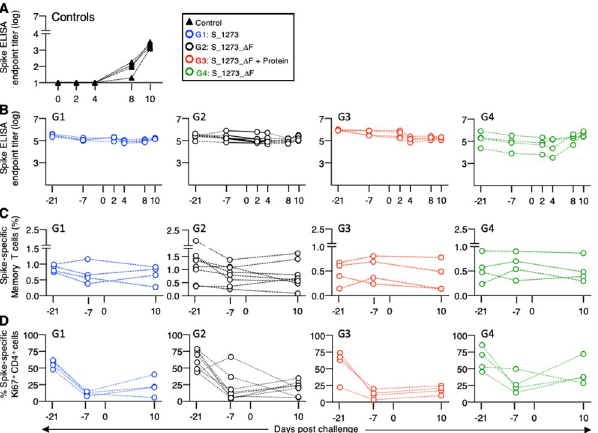
Fig 5. Post-challenge immune responses. ( A, B ) Anti-Spike antibodies measured by ELISA (reciprocal endpoint titer, log) in the ( A ) control animals over the course of infection up to day 10, and ( B ) in the vaccinees at -day 21 (2 weeks after the last vaccination) and -day 7 (4 weeks after the last vaccination) before challenge and days 2, 4, 8, and 10 after challenge. ( C, D ) Antigen-specific memory T cell responses were monitored from 2 weeks after the last vaccination to 10 days after infection showing ( C ) % of Spike-specific total IFN- γ + memory T cells and ( D ) Spike-specific Ki67 + IFN- γ + memory CD4 + T cells, shown as % of the antigen-specific total memory CD4 + T cell subset.